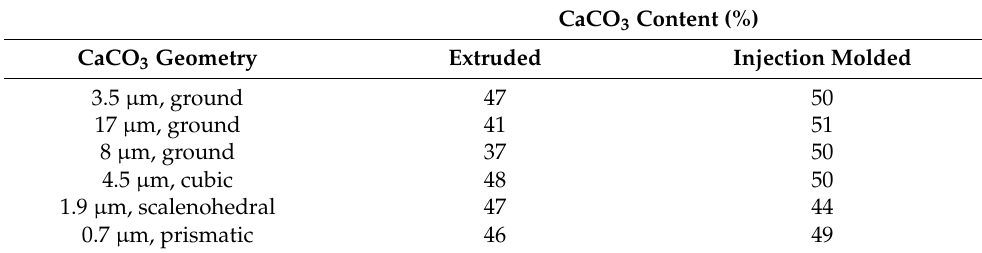
Table 2. TGA experimental findings of CaCO 3 content.